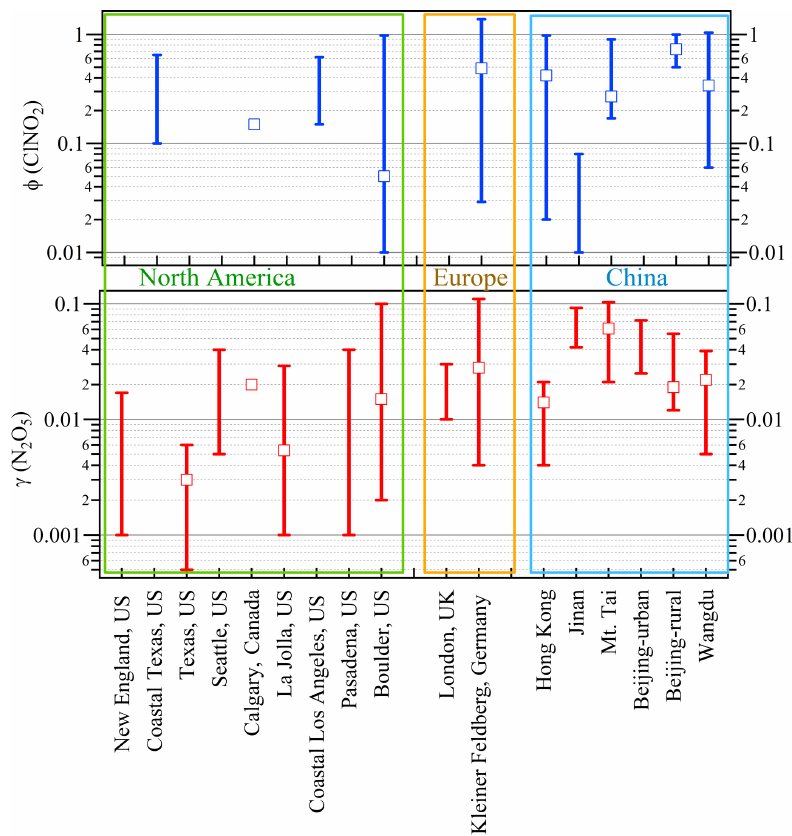
Figure 4. Comparison of the field-observed N 2 O 5 uptake coefficient and ClNO 2 yield from previous studies. Stick bars represent the range of the reported values, and cube represent the median or average values reported in these measurements. The corresponding references are listed in Table